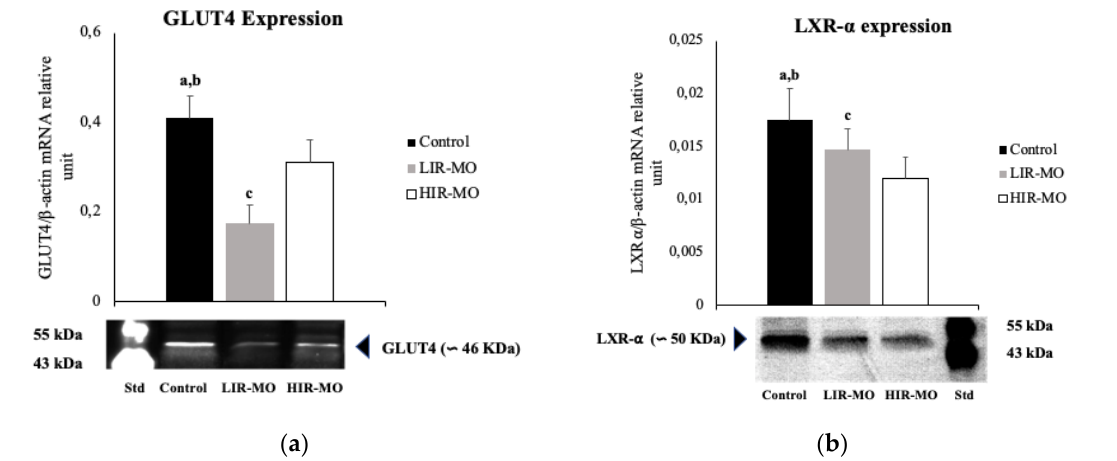
Figure 1. GLUT4 ( a ) and LXR- ⍺ ( b ) mRNA expression and GLUT4 and LXR- ⍺ protein levels in VAT from lean individuals and morbidly obese patients. The mRNA expression of GLUT4 and LXR- ⍺ was normalized to β -actin levels. GLUT4 and LXR- α mRNA expression levels in VAT in the controls (black bar) ( n = 11), LIR-MO (grey bar) ( n = 15), and HIR-OR groups (white bar) ( n = 19). The results are given as the mean relative mRNA expression ± standard deviation. Different letters indicate significant differences between the means of the different groups of subjects ( p < 0.05; a: controls vs. LIR-MO; b: controls vs. HIR-MO; c: LIR-MO vs. HIR-MO) according to Student’s t -test. Abbreviations: GLUT4: glucose transporter type 4; LXR- α : liver X receptor type alpha; LIR-MO: low insulin resistance